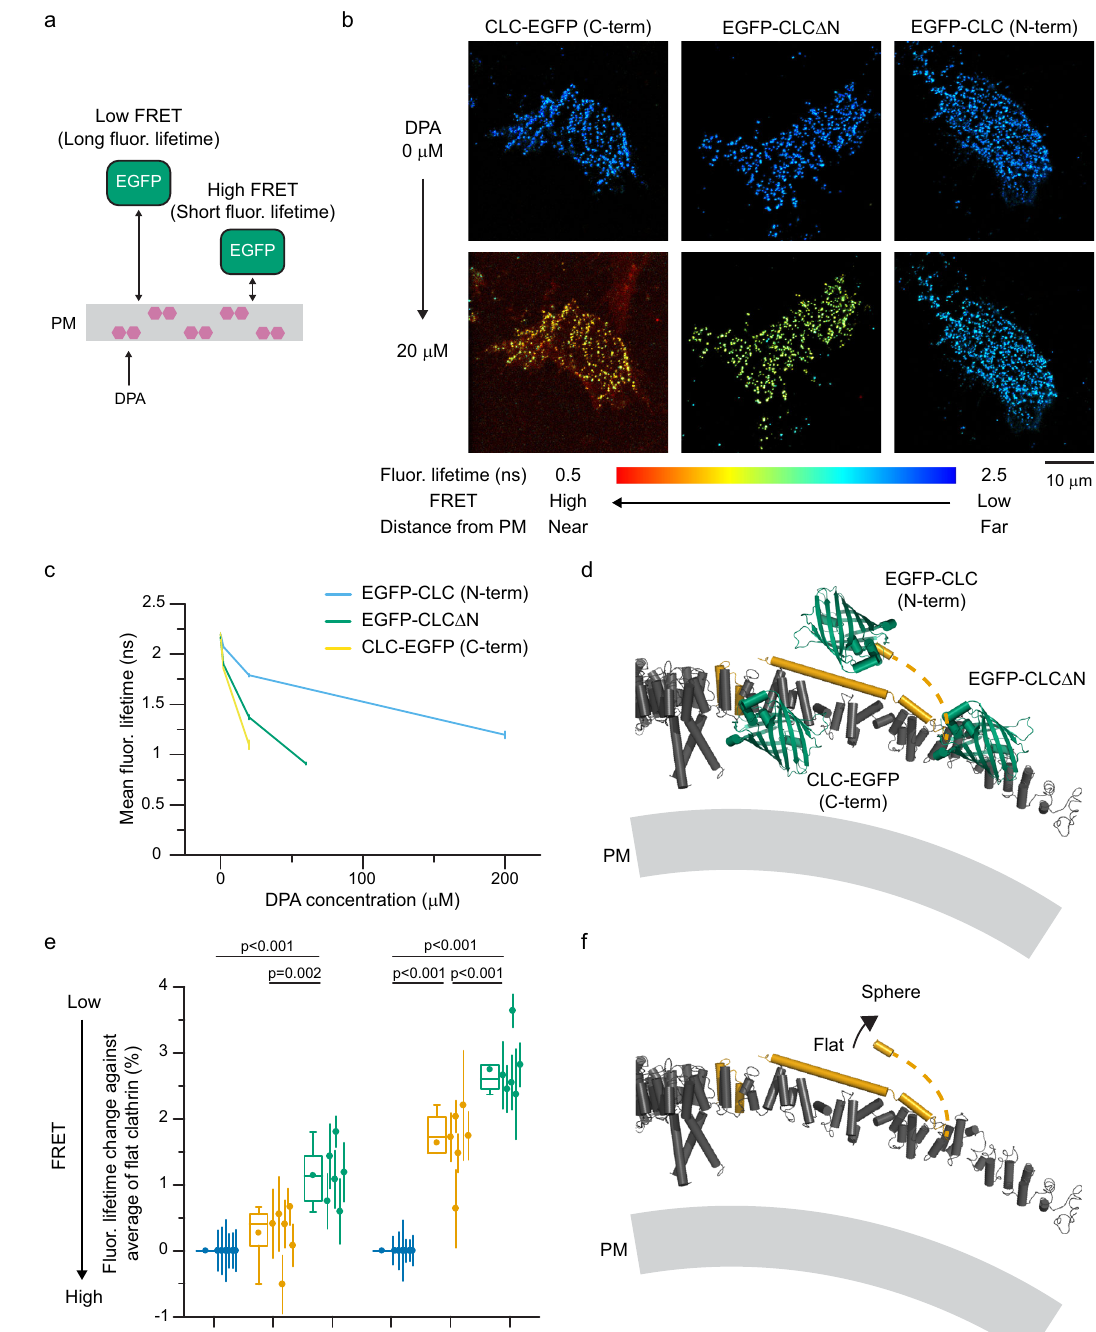
Fig. 3 | CLC N-terminal position perpendicular to the plane of the plasma membrane. a Dipicrylamine (DPA) is a non fl uorescent hydrophobic anion that incorporates into membranes. DPA quenches EGFP in a distance dependent man- ner by FRET. PM is the plasma membrane. b FLIM images of unroofed membranes ofHeLacellsexpressingCLC-EGFP(left),EGFP-CLC Δ N(center),orEGFP-CLC(right) without (top) or with 20 μ M DPA (bottom). Scale 10 μ m. c Mean fl uorescence lifetimes with different DPA concentrations. n =16 (EGFP-CLC), 17 (EGFP-CLC Δ N), and 15 cells (CLC-EGFP) from 3 experiments. Errors are SE. d A structural model of EGFPpositionsofCLCprobespredictedfromtheEGFP-DPAFRETexperiments.The model is based on PDB 4KW4 and 3LVG. e FRET-CLEM on HeLa cells expressing either CLC-EGFP or EGFP-CLC with DPA. DPA concentrations were 3 μ M for CLC- EGFPand80 μ MforEGFP-CLCtoobtain~50%FRETef fi cienciestomakethedegree